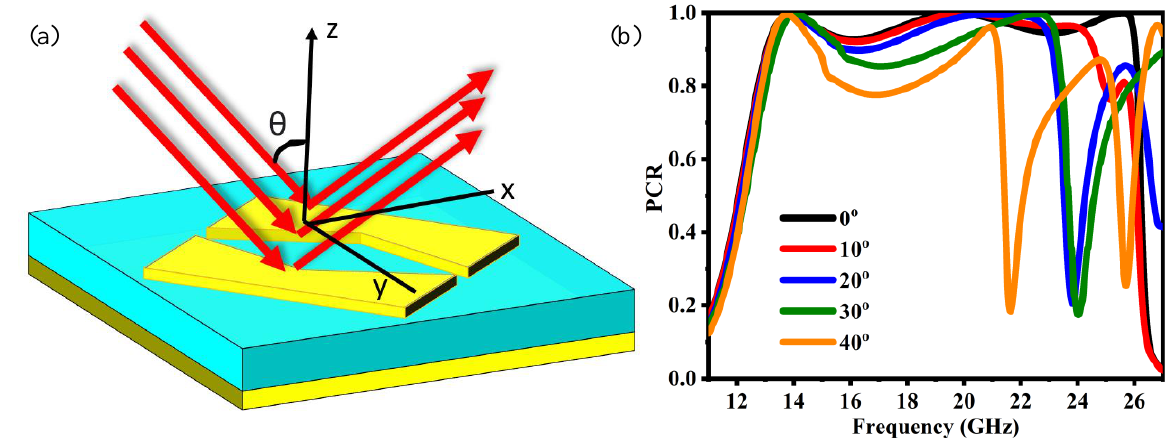
Figure 6. ( a ) Schematic representation of the proposed anisotropic reflective metasurface under oblique incident wave; ( b ) angular dependent PCR of the proposed anisotropic reflective metasurface.